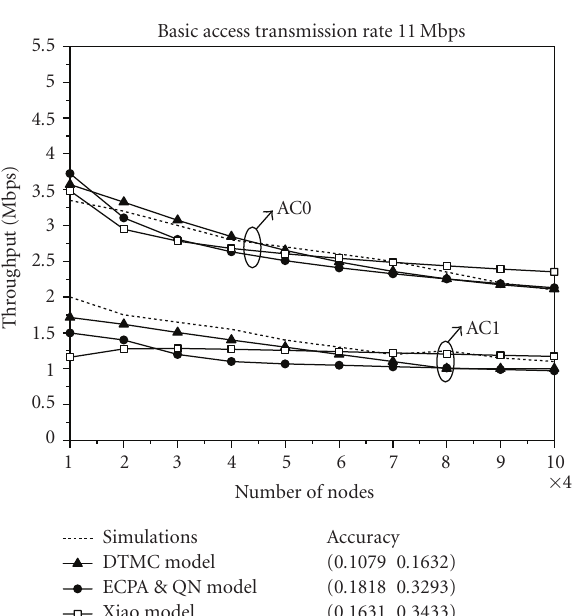
Figure 5: Model comparison in terms of saturation throughput us- ing basic access method at 11 Mbps transmission rate.